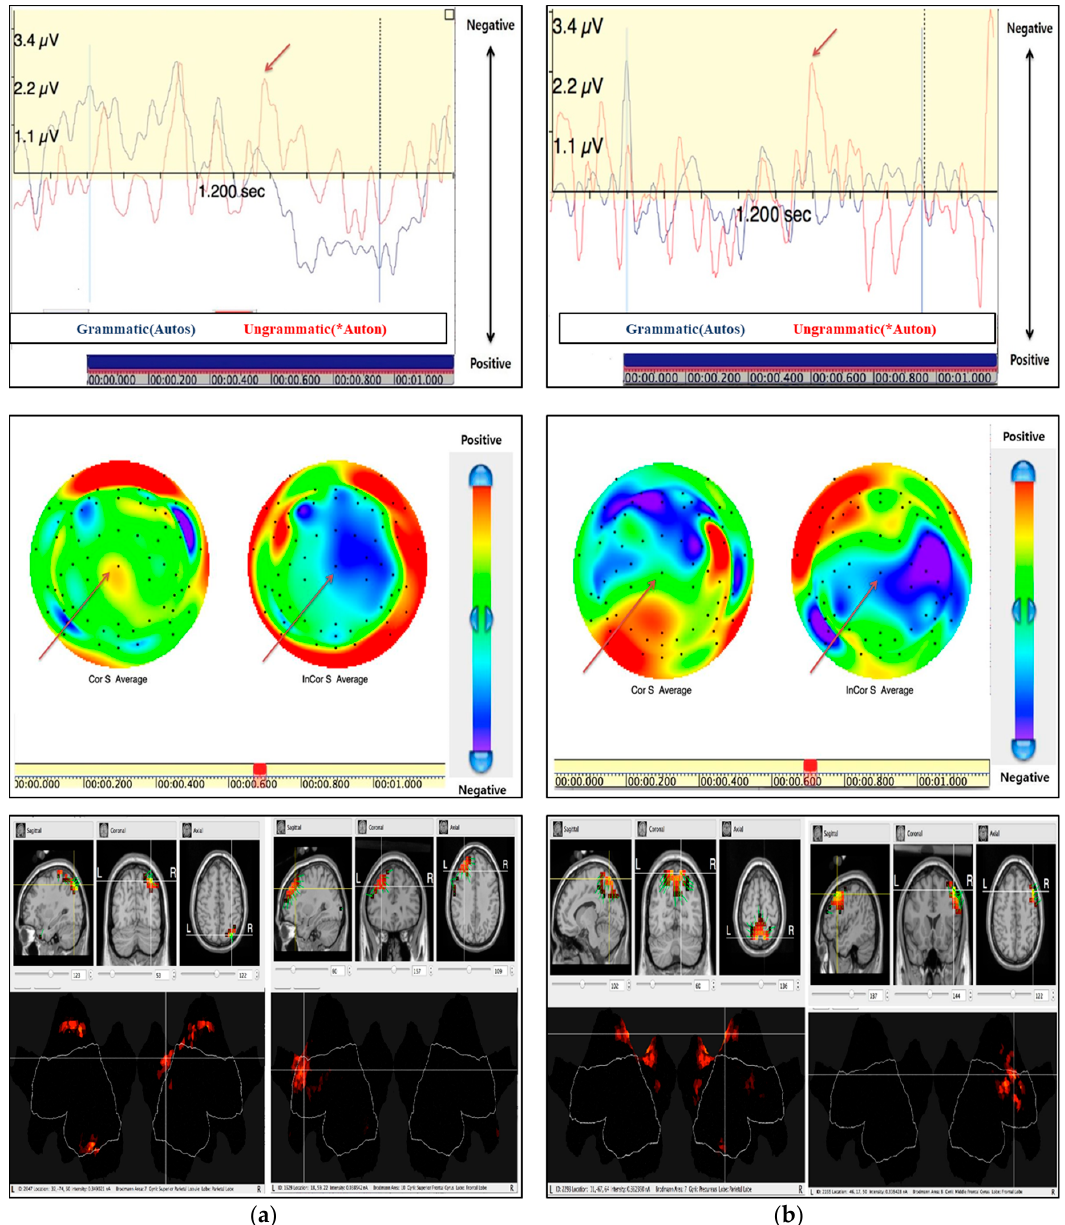
Figure 2. N400 (Cz) by irregular ending violation between low ( a ) second language (L2) and high ( b ) L2 learners.